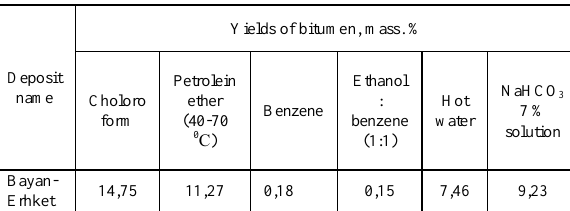
Table 1. The yields of the bitumens isolated by extraction of various organic solution and hot water from bituminous